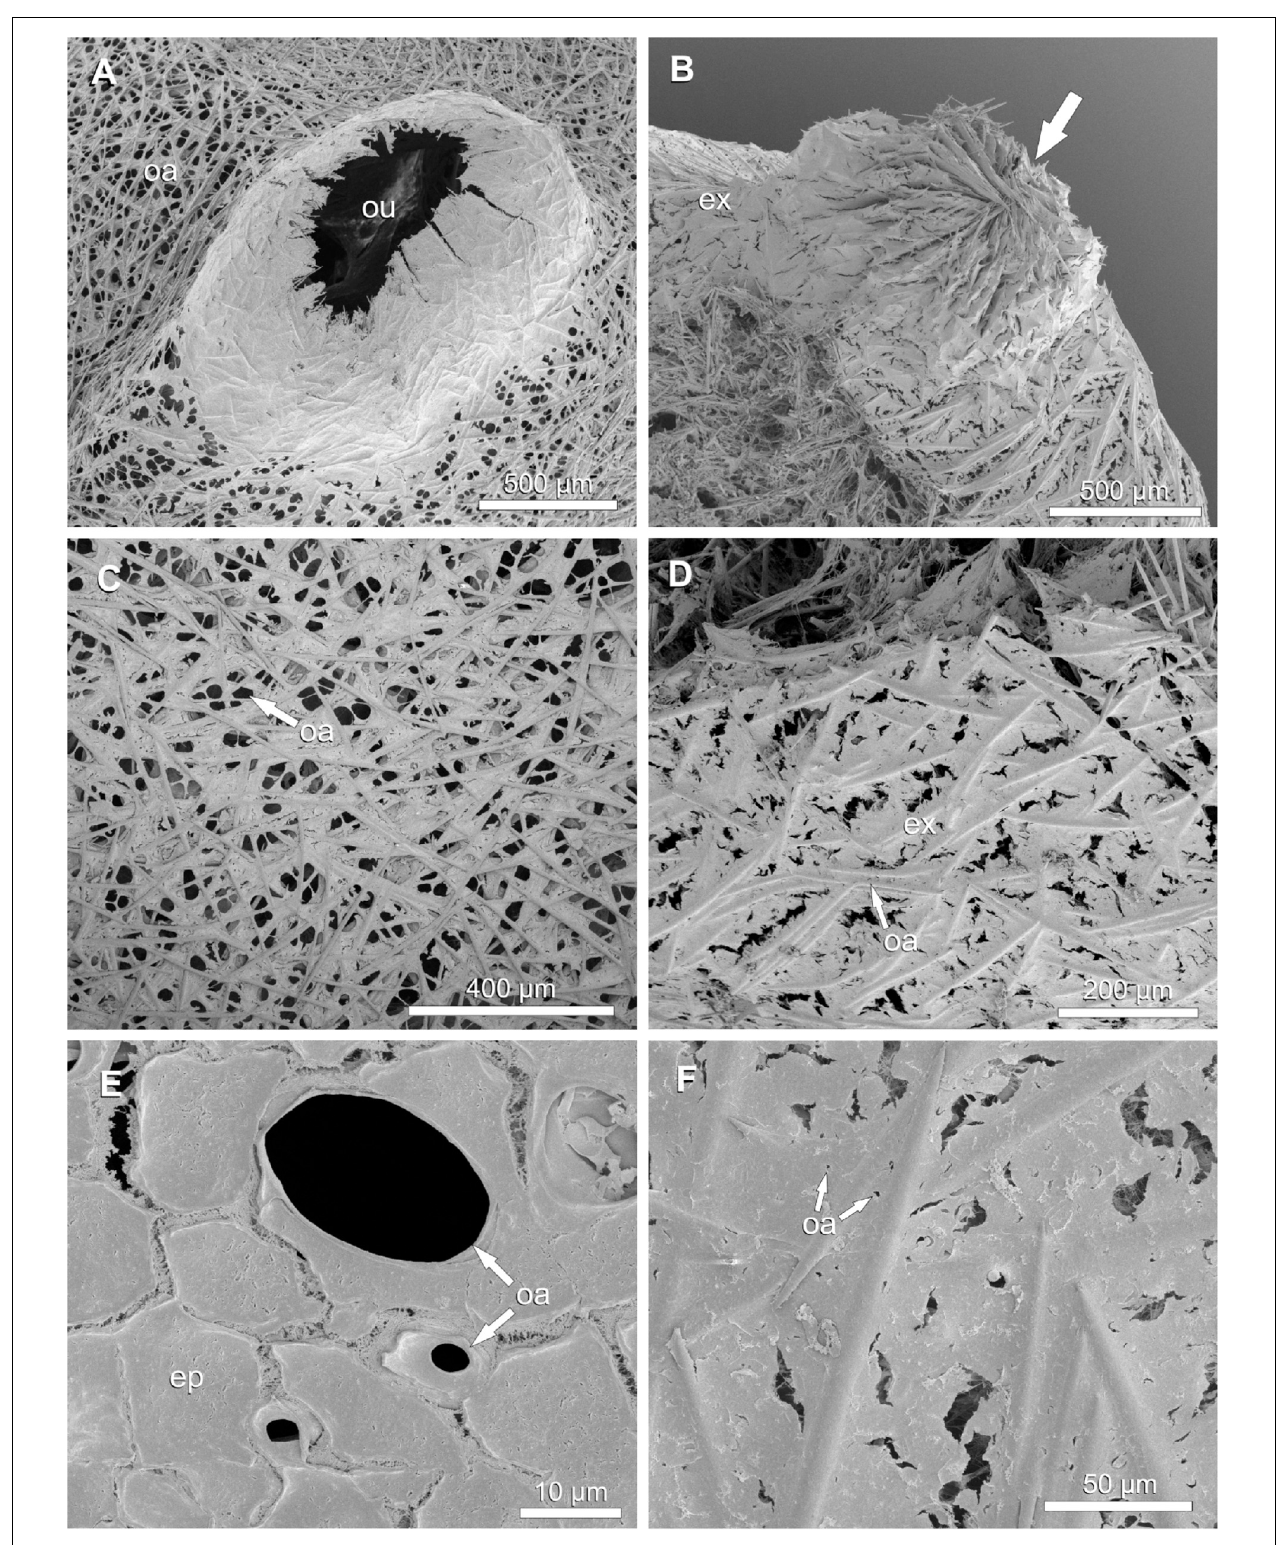
FIGURE 5 | Halichondria panicea , SEM. External morphology of expanded and contracted single-osculum explants. (A,C,E) Expanded, untreated explant; (B,D,F) contracted explant after exposure to 1 mM GABA. (A) Osculum, expanded. (B) Closed osculum, note arrangement of radial spicule bundles (arrow). (C) Exopinacoderm with high density of expanded ostia. (D) Exopinacoderm with closed ostia. (E) Three ostia (porocytes) with variable degree of openness. (F) Close-up view of ostia during contraction of the sponge explant. Legend: ep: exopinacocyte, ex: exopinacoderm, oa: ostia, ou: osculum.